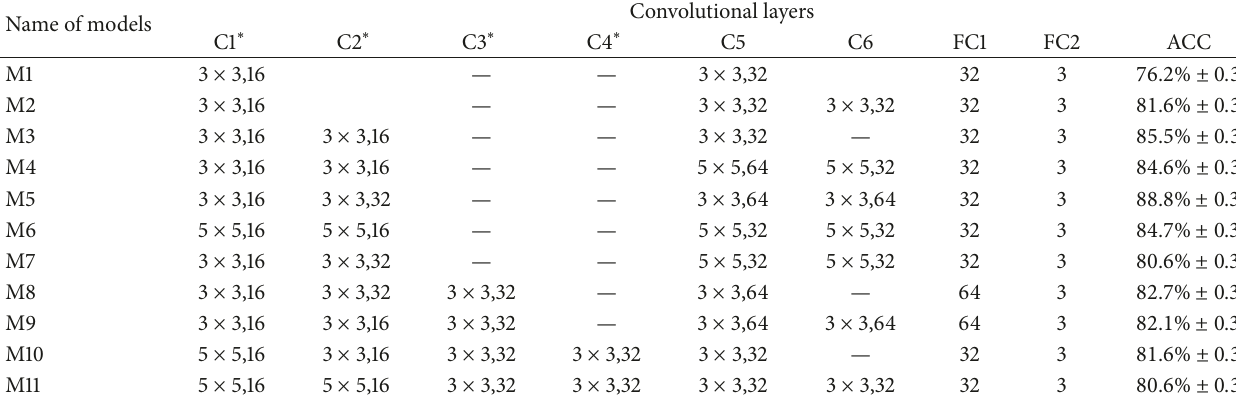
Table 1: Architecture of models with different number of layers before merging.